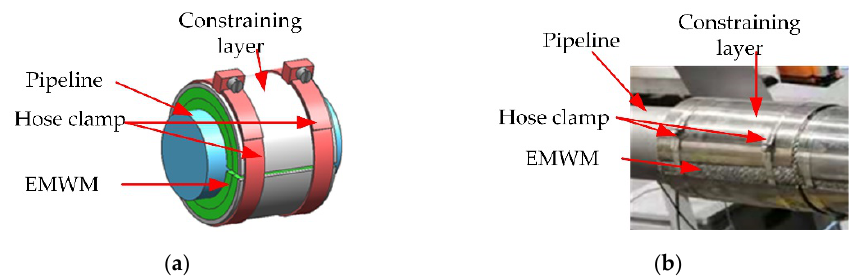
Figure 1. Scheme of the long coated damping structure. ( a ) schematic diagram; ( b ) physical picture.